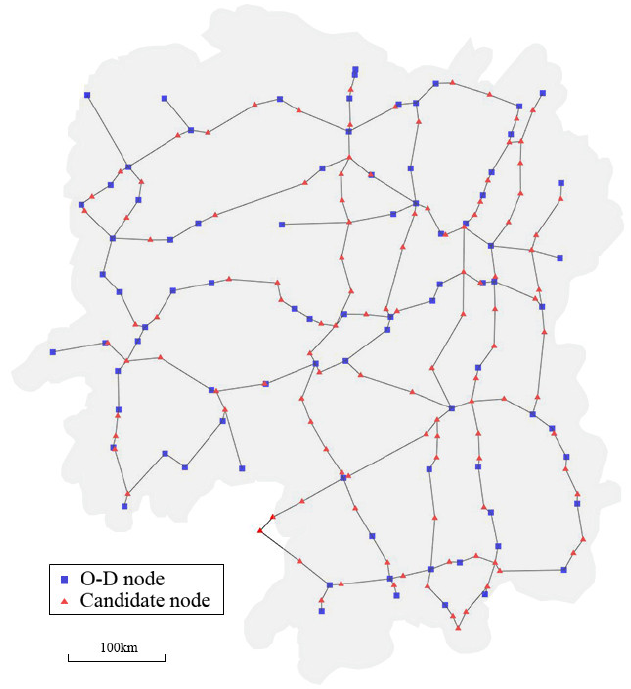
Figure 4. Highway network of Hunan Province.